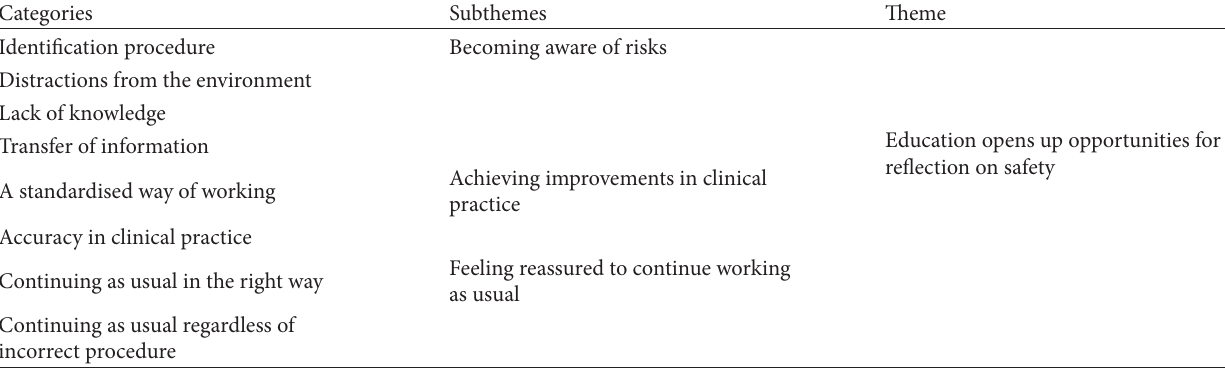
Table 1: Overview of the categories, subthemes, and theme revealed during the